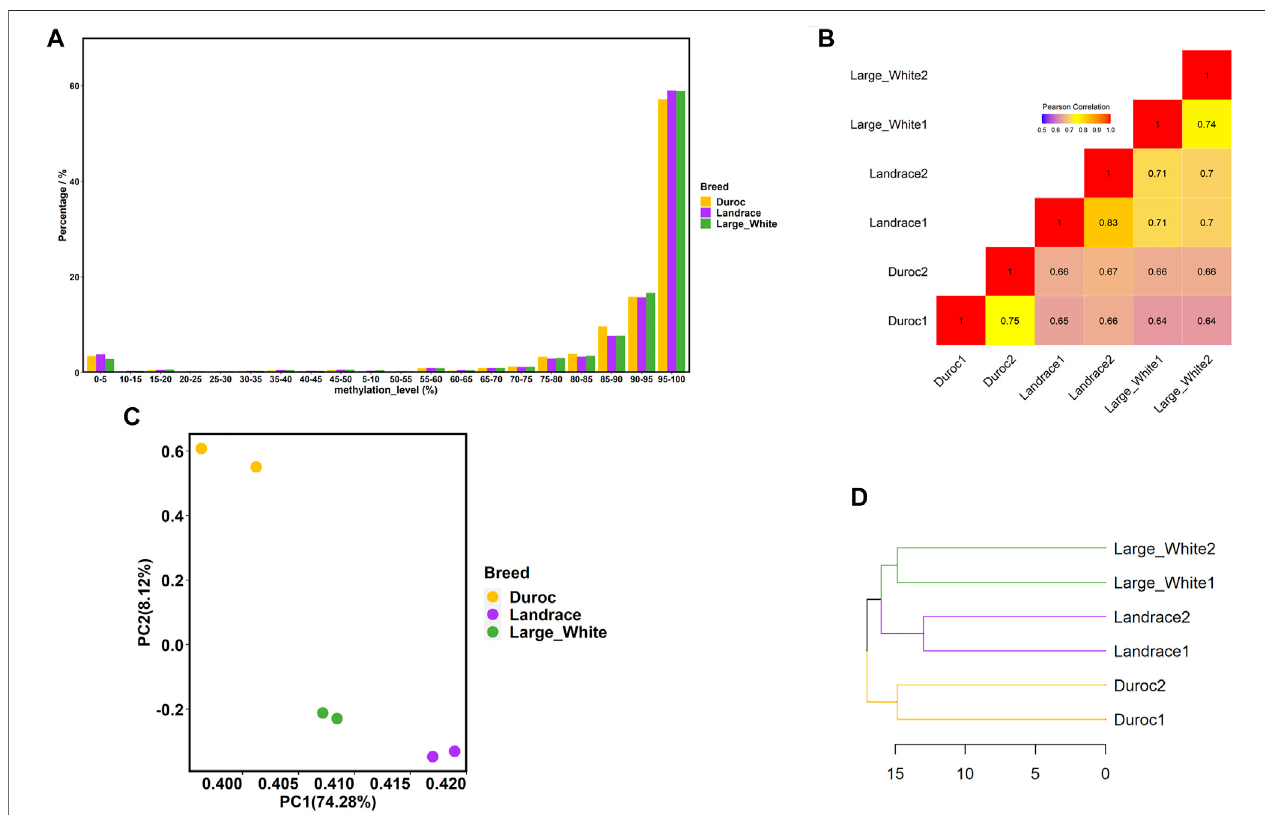
FIGURE 2 | Porcine sperm DNA methylome characteristics. (A) Distribution of methylation levels of CpG sites (only CpG sites covered by at least fi ve reads were included). (B) Correlation analysis between each sample using common CpG sites. (C) PCA of methylation levels in six samples using common CpG sites. (D) Hierarchical clustering of three pig breeds based on the methylation level of promoter